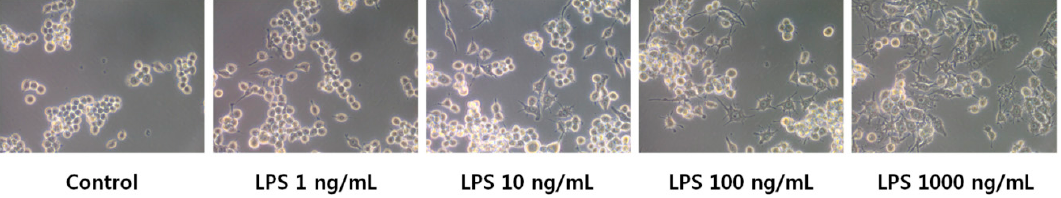
Figure 2. Morphological changes in RAW264.7 cells treated with 0, 1, 10, 100, and 1000 ng/mL lipopolysaccharide (LPS). The morphology of RAW 264.7 cells was visualized by optical microscopy (400×).